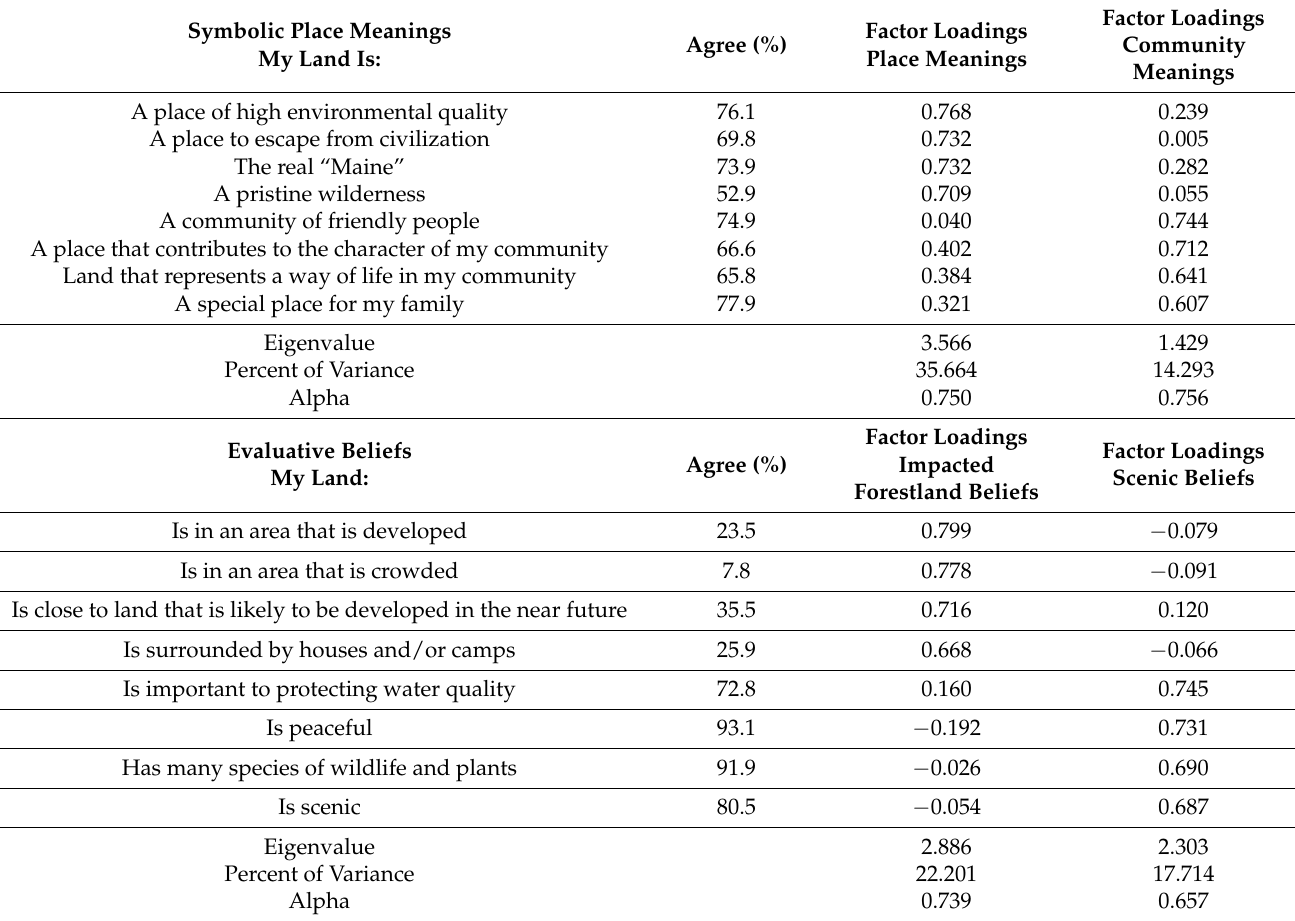
Table 1. Factor analysis of symbolic place meanings and evaluative beliefs